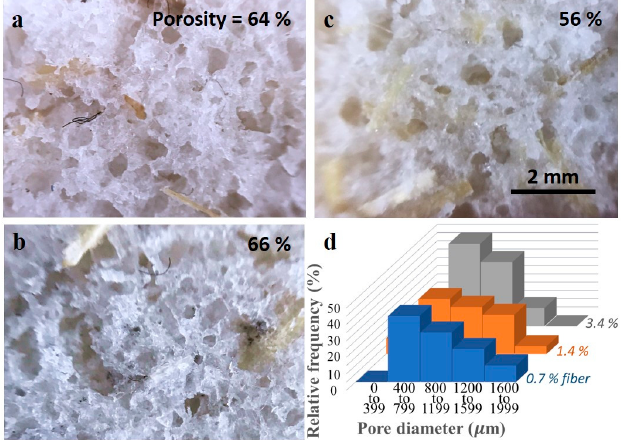
Figure 5. Optical microscopy images of BF-PDMS with ( a ) 0.7%, ( b ) 1.4%, and ( c ) 3.4% fiber loadings. Distribution of pore size is given in ( d ).